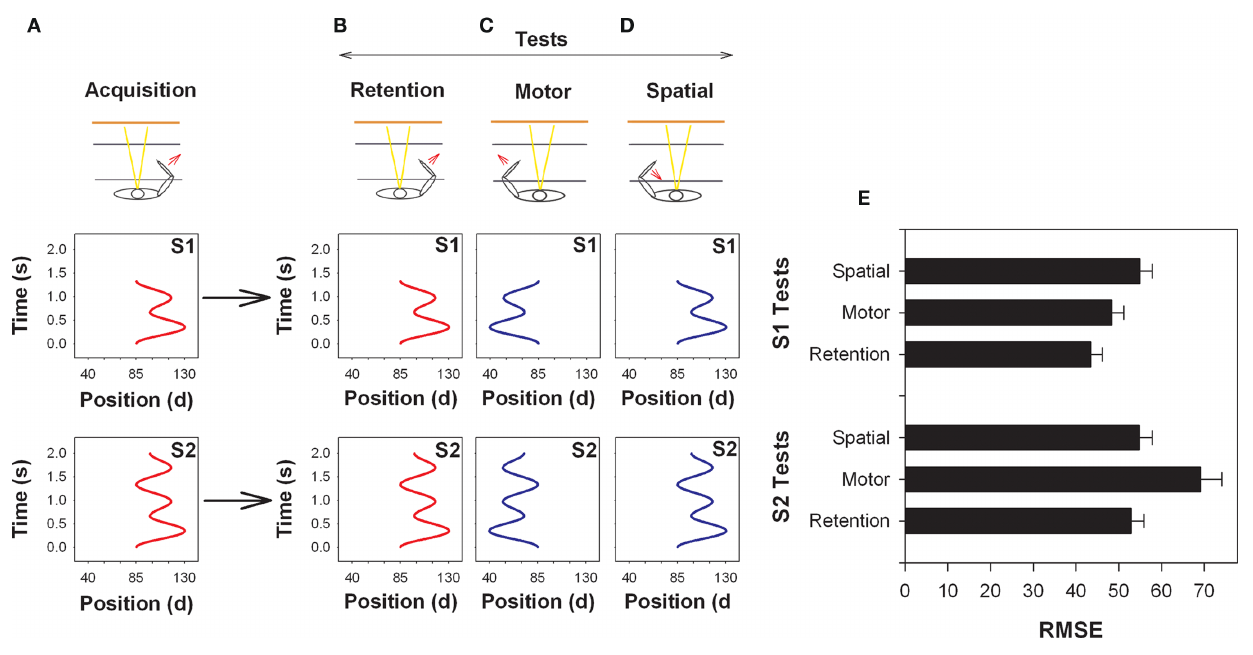
Figure 3 | illustration of the arm used during acquisition (A) and on the retention (B), motor (C) and spatial (D) tests. The arm used and direction of movement is indicated by an arrow (bottom) and the goal movements (top) are